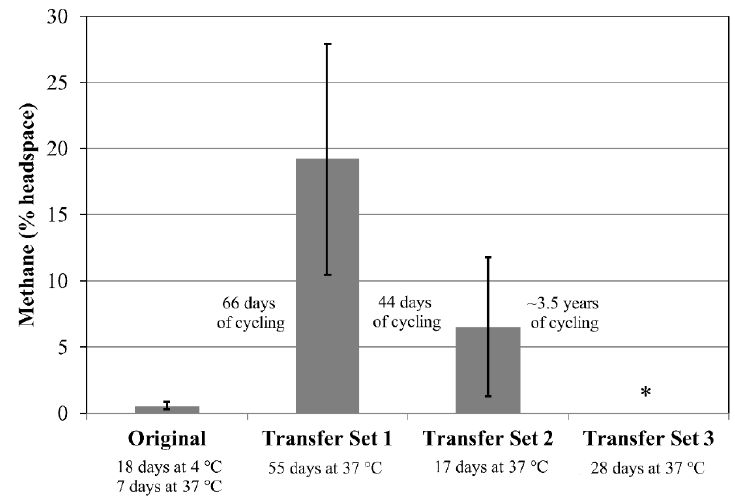
Figure 4. Methane production by Methanobacterium formicicum following an initial incubation period for each of three sets. Test tubes for the Original Set and for Transfer Sets 1 and 2 contain 10 g sand and 5 mL MSF medium. Transfer Set 3 tubes contain 10 mL MSF medium only. Transfer Set 1 tubes ( n = 4) were inoculated from one tube in the Original Set ( n = 4) following 91 days of freeze/thaw cycles. Transfer Set 2 tubes ( n = 4) were inoculated from three separate test tubes from Transfer Set 1 following 99 days of freeze/thaw cycles. Transfer Set 3 tubes ( n = 4) were inoculated from the corresponding tube in Transfer Set 2 after 1474 days of freeze/thaw cycles. Specific freeze/thaw cycles (time, temperature) are given in Table 3. Specific inoculation schemes between sets are given in the supplementary material. The asterisk indicates that no methane was detected. Error bars indicate ± one standard deviation.